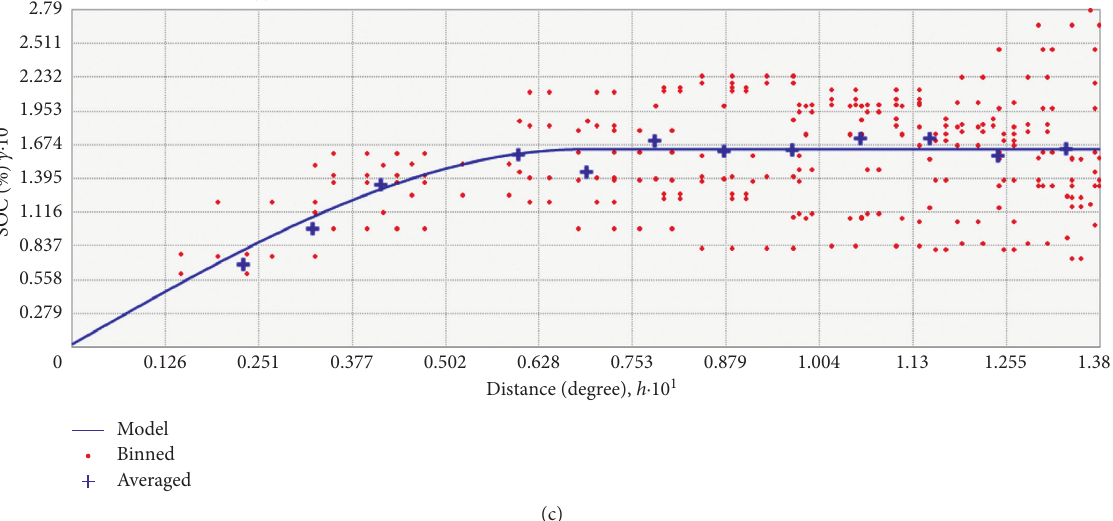
Figure 2: Fitted semivariograms illustrating the strength of statistical correlation between major soil nutrients: (a) pH, (b) electrical conductivity (EC), and (c) soil organic carbon (SOC) in the study